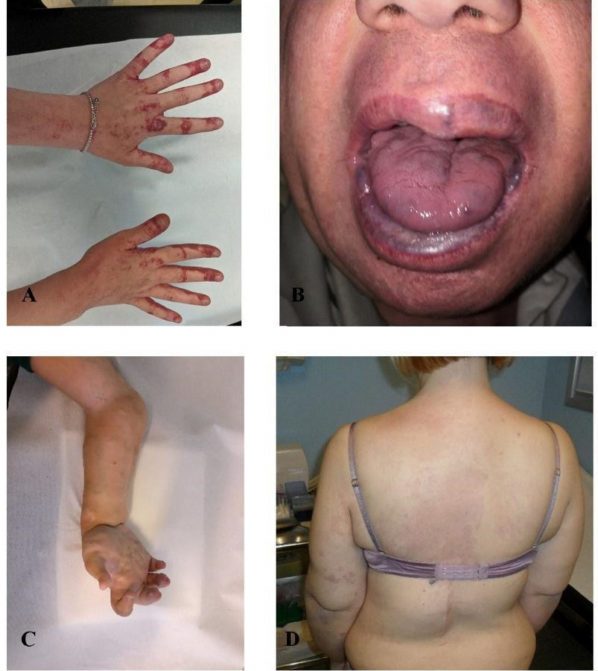
Figure 4. Lymphovenous malformations. ( A ) patient 13, ( B ) patient 14, ( C ) patient 15, ( D ) patient